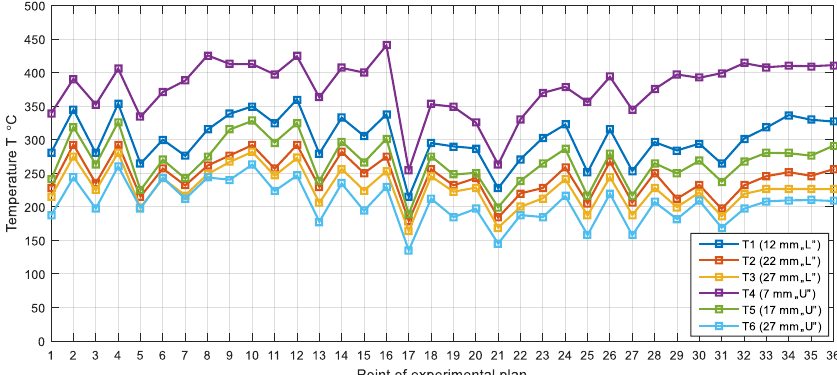
Figure 15. The obtained values of the welding temperature in the adopted measuring positions, for all points of the experimental plan.